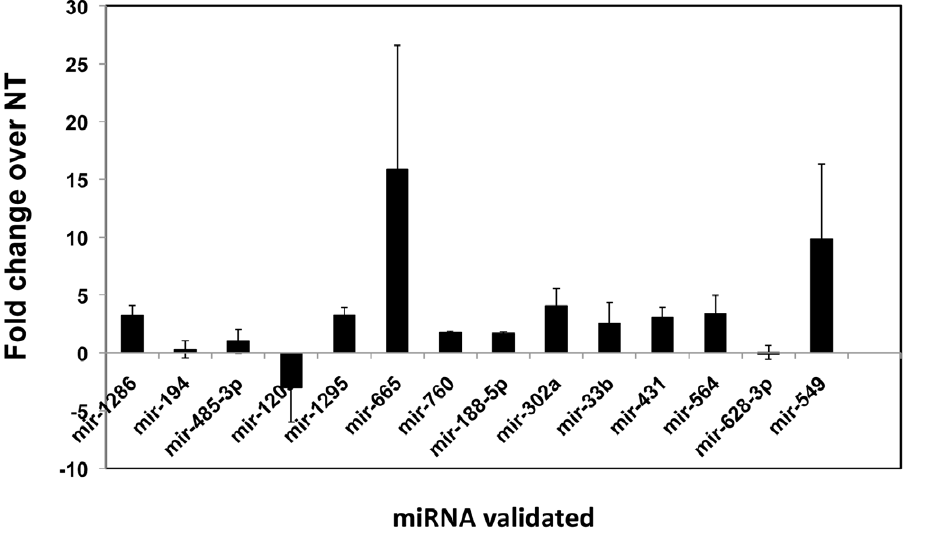
Figure 3. Quantitative real time RCR (qRT-PCR) confirmation of randomly selected miRNAs from the microarray analysis. The expression of selected miRNAs in PBMCs infected with HIV-1 along with the expression of uninfected controls were tested for validation by qRT-PCR using a specific primer and probe for each miRNA. Fold increase/decrease was calculated based on endogenous control normalization. Average fold change for each miRNA represents fold change obtained from 10 independent